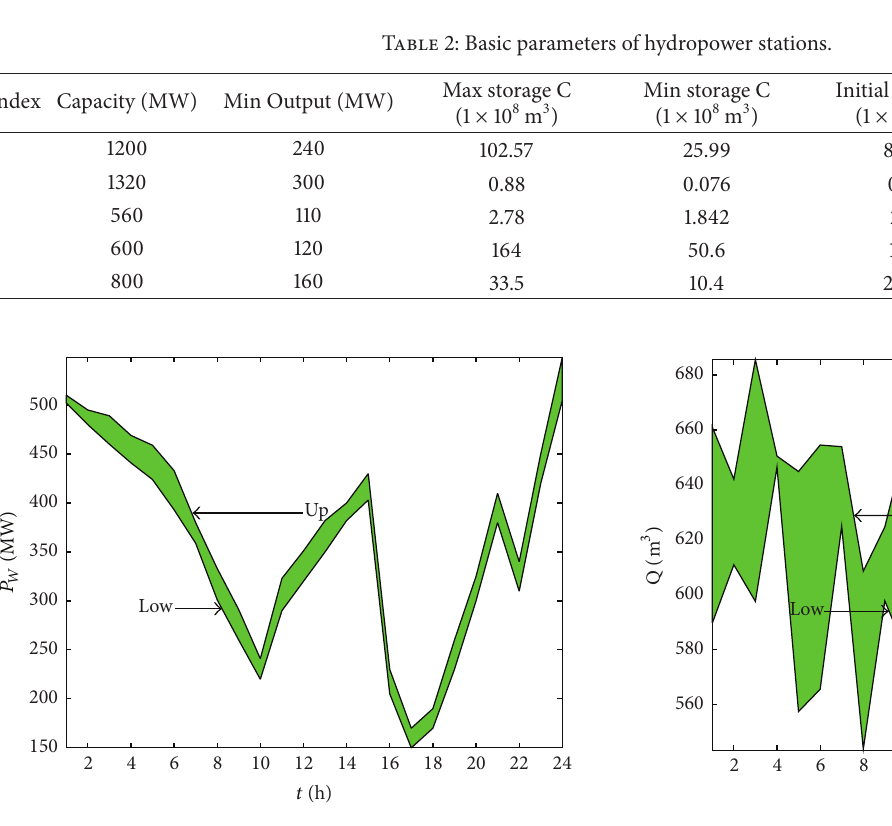
Figure 4: Prediction of hydropower plant runoff interval